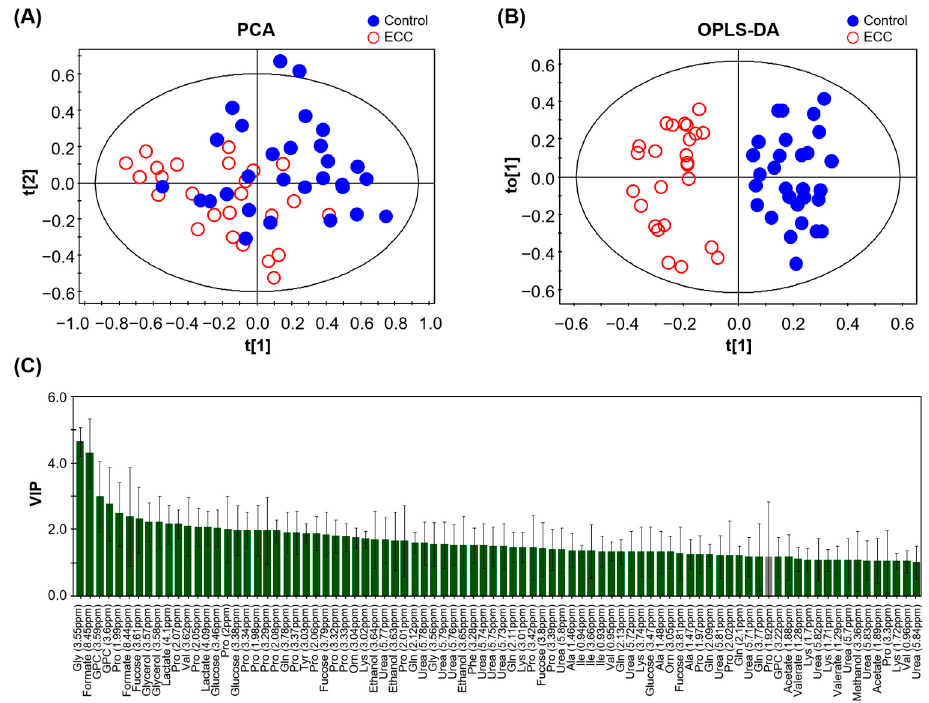
Figure 2. PCA ( A ) and OPLS-DA ( B ) score plots of 1 H NMR spectra of saliva samples from study participants with caries (ECC) and the healthy control (Control). ( C ) VIP scores of the influential contributing variables in the OPLS-DA with the jack-knife standard error (VIP > 1.0). Green bars represent the values that satisfy the set criteria (VIP/VIP cvSE >1.0), and gray bar denotes those that do not (VIP/VIP cvSE < 1.0). Abbreviations: Ala: Alanine; Gln: Glutamine; Gly: Glycine; GPC: Glycerophosphocholine; Ile: Isoleucine; Lys: Lysine; Orn: Ornithine; Pro: Proline; Tyr: Tyrosine; Val: Valine.